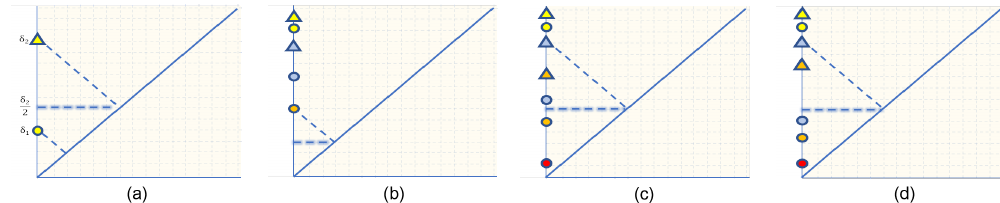
Figure 2. Examples of point-matching between persistence diagrams highlighting the resulting bottleneck distance. Points in each diagrams are shape coded and matched points are color